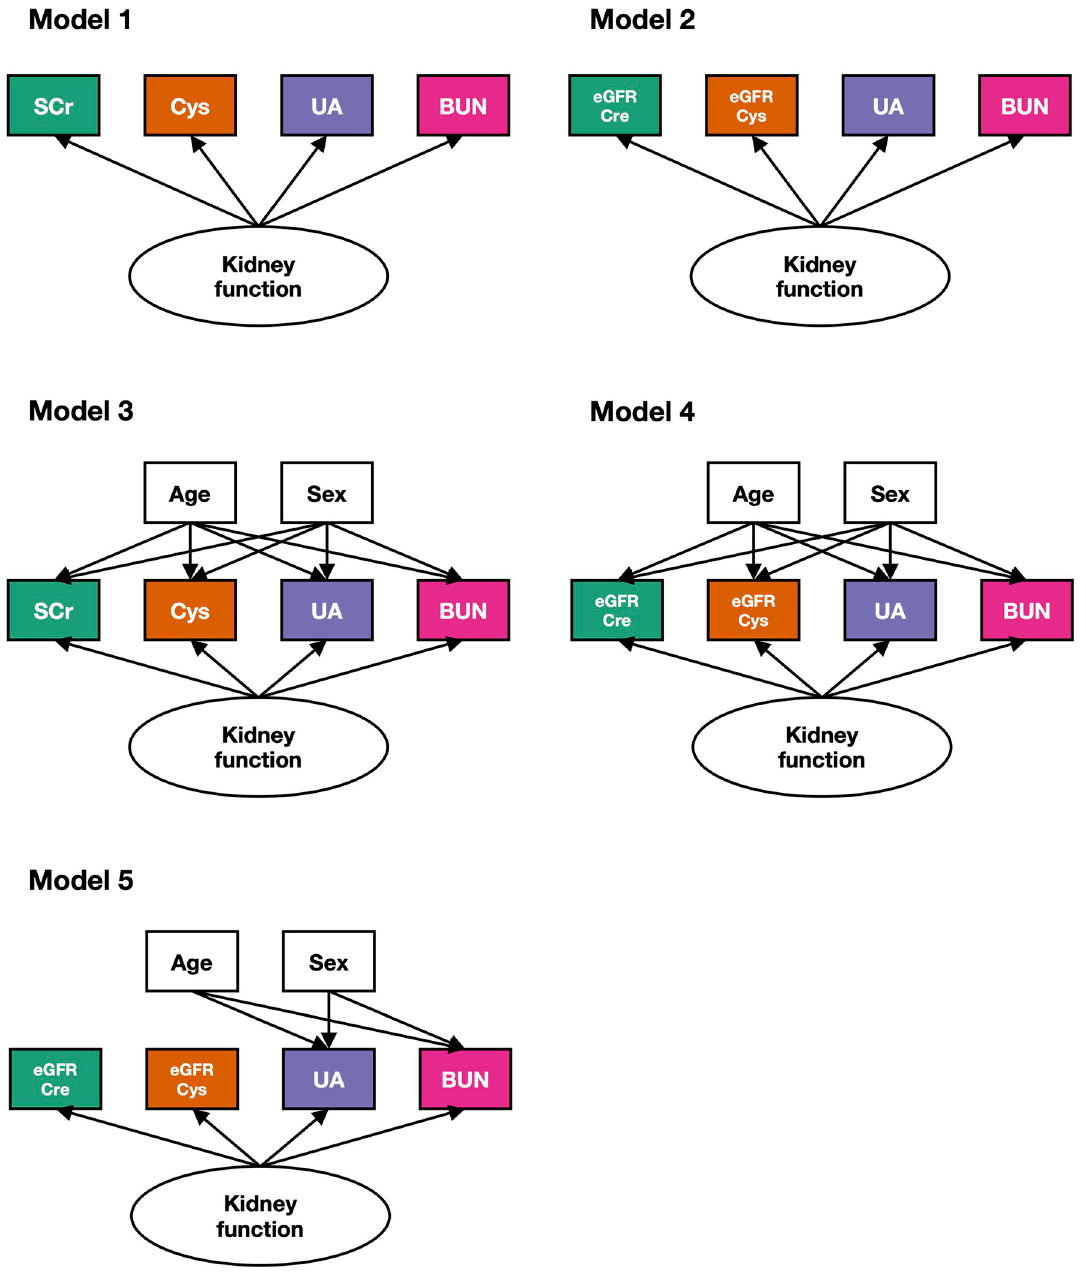
Fig 2. SEM conceptual framework under different assumptions (model 1–5). We developed five models based on different combinations of kidney biomarkers and demographic variables (sex and age). Circles represent latent variables and squares represent observed variable. BUN: blood urea nitrogen; Cys: cystatin C; eGFRcre: creatinine-based eGFR (eGFR CKD-EPI Cre 2021 ); eGFRcys: cystatin c-based eGFR (eGFR CKD-EPI Cys ); SCr: serum creatinine; UA: uric